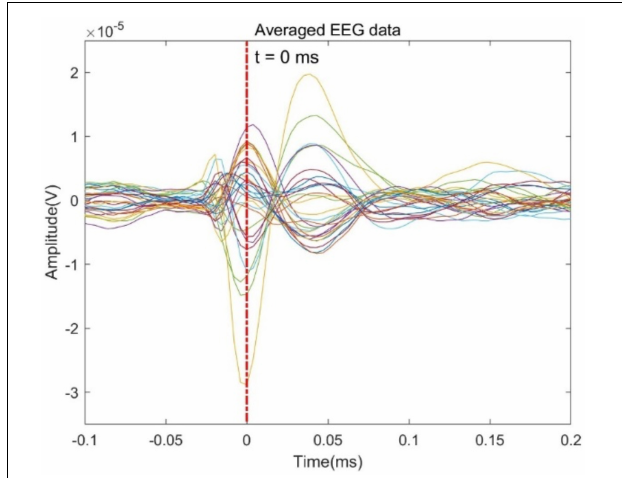
FIGURE 9 | Average EEG time series plot around the inter-ictal spike.